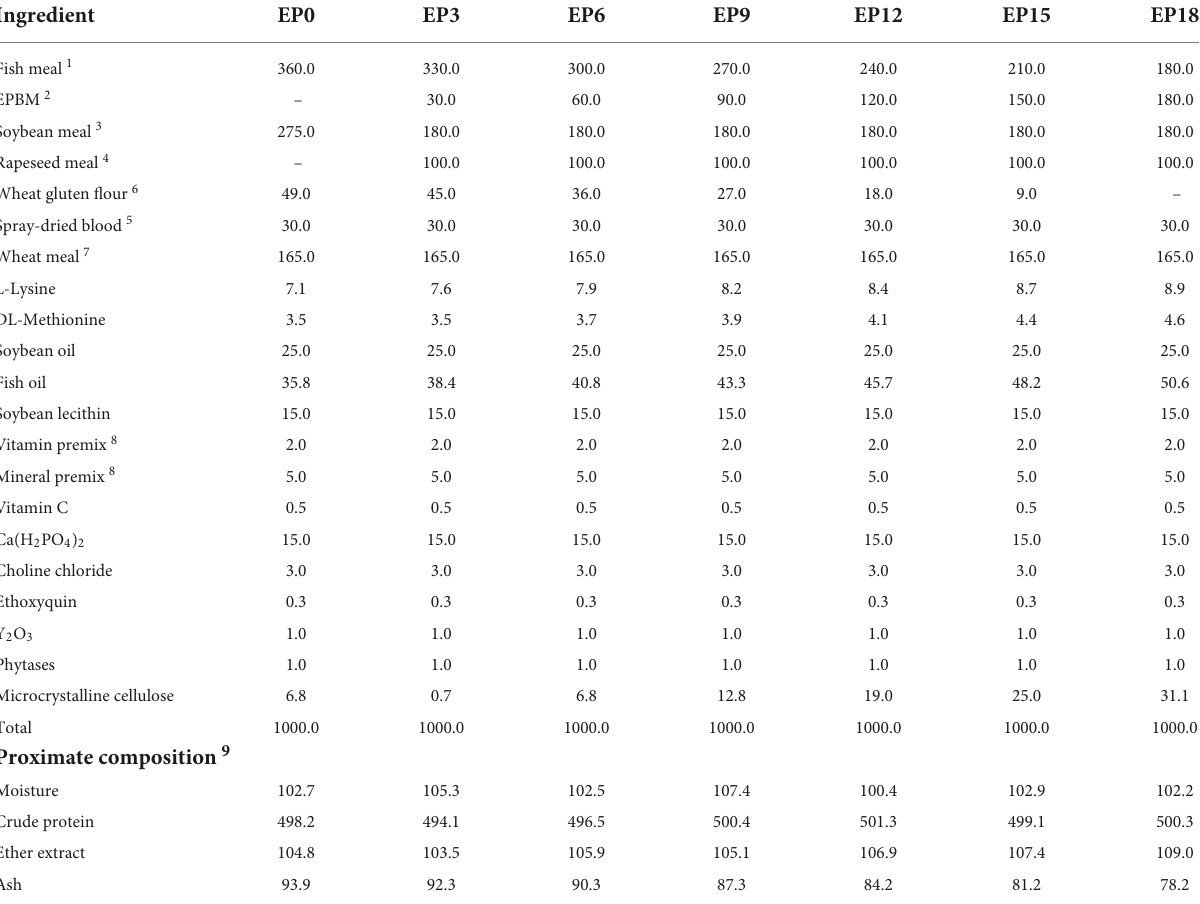
TABLE 1 Formulation and proximate composition of the experimental diets (g/kg, dry